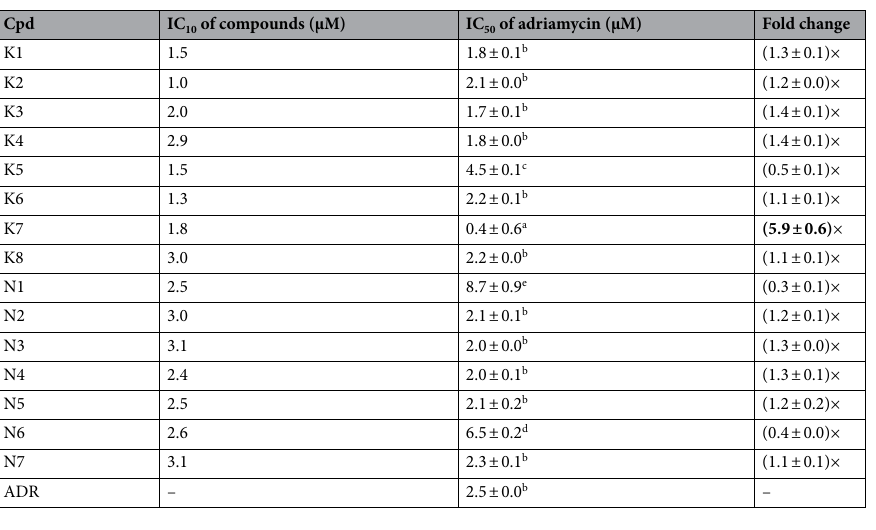
Table 3. Sensitization potential of selenoesters against the Adriamycin-resistant human ovarian carcinoma cell line HOC/ADR. Tested compounds were applied in single dose (IC 10 ) and Adriamycin in the indicated concentration range (0.1–20 µM) in order to determine its concentration halving the cell viability (IC 50 ). Fold change was calculated as the ratio of IC 50 of Adriamycin and IC 50 of Adriamycin in the presence of IC 10 dose of compounds. Data are expressed as the average inhibitory concentrations (IC 50 ) or fold change of three repetitions with standard error of the mean (SEM). Fold change higher than 1 indicated the synergistic effect of cytotostatic and tested compound. The statistical differences between compounds were calculated by one-way analysis of variance (ANOVA) and Duncan’s post hoc test (p ˂ 0.05), where the significances were denoted by different letters (a–e). Significant values are in